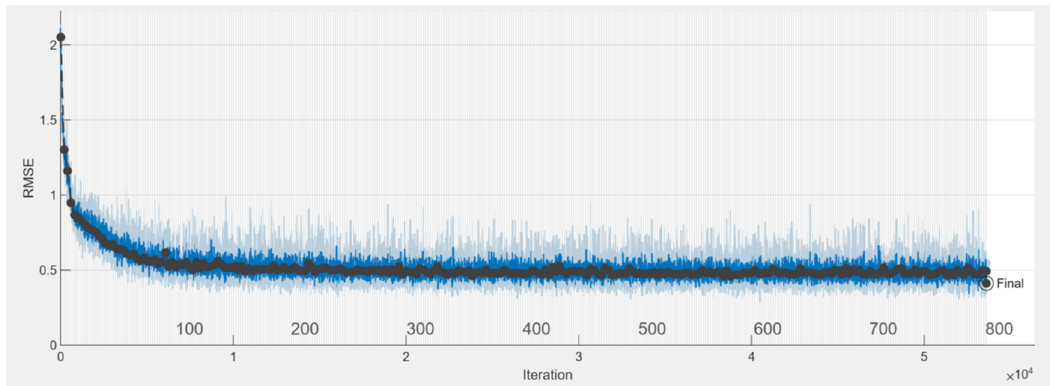
Figure 9. Trend of RMSE during the training (blue—training set, black—validation set). Residuals are a measure of how far from the regression line data points are; RMSE is a measure of how spread these residuals are.